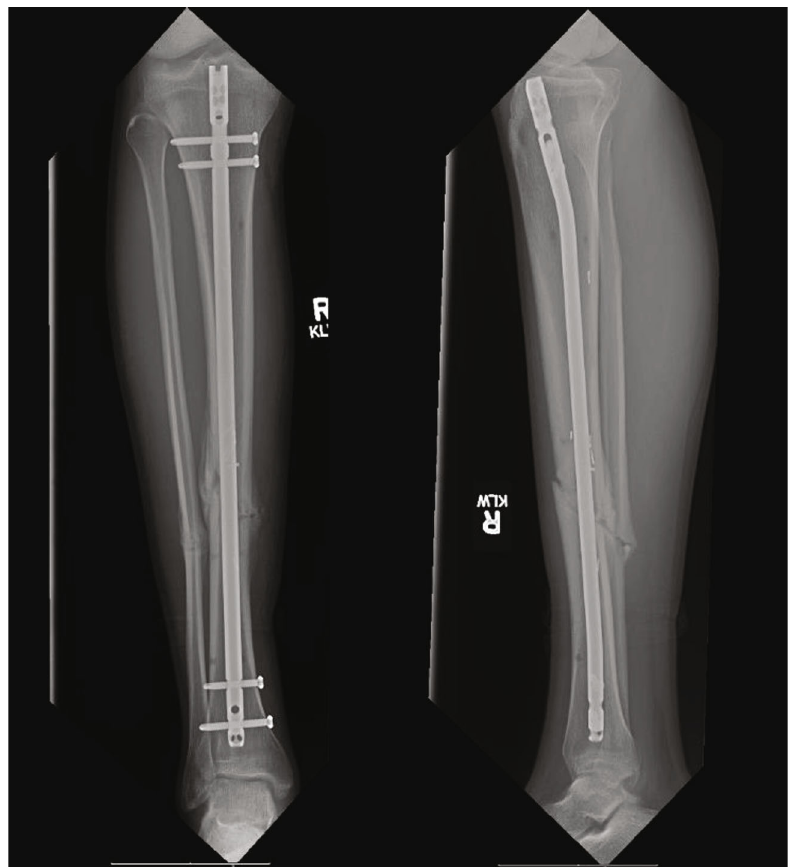
Figure 5: Three-month postoperative radiographs. AP and lateral radiographs at three months postoperatively demonstrate fracture